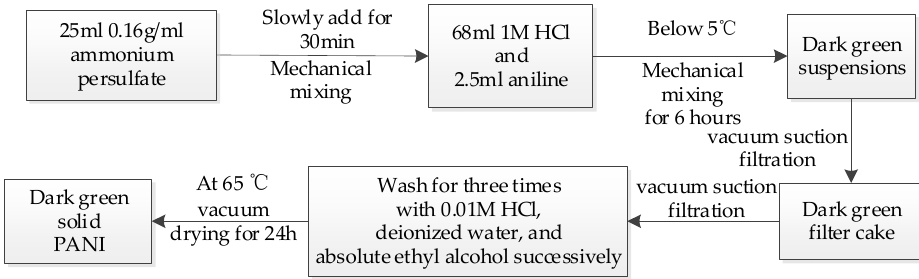
Figure 1. Preparation process flow chart of polyaniline (PANI).